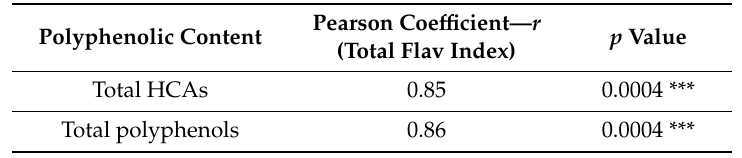
Table 5. Pearson correlation analysis between the non-destructive (Dualex ® ) and destructive contents of polyphenols ( n =